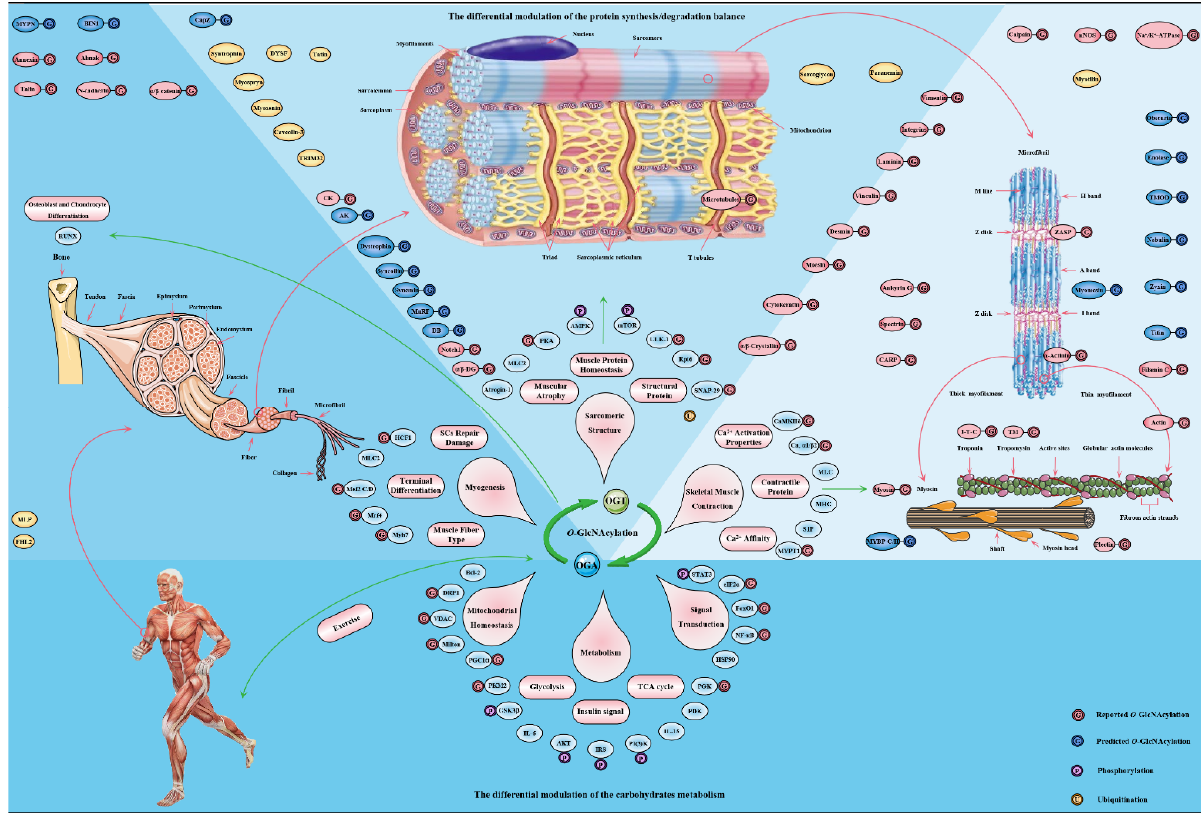
Figure 5. The major targets and pathways shown to be altered by O ‐ GlcNAcylation in in the skeletal muscle physiology . Thousands of O ‐ GlcNAcylated proteins have been identified in skeletal muscle cells. These O ‐ GlcNAcylated proteins are classified into contractile proteins, sarcolemma proteins, structural proteins and cytoskeletal proteins, as well as mitochondrial proteins, metabolic enzymes, transcription factors and signal proteins. Therefore, the effects of O ‐ GlcNAcylation on various phys ‐ iological processes of skeletal muscle may be realized from the following four aspects: ( 1 ) its regu ‐ lation of carbohydrate metabolism with sensing nutritional availability; ( 2 ) its maintenance of struc ‐ tural protein synthesis/degradation balance; ( 3 ) its improvement of sarcomere contractile activity by modulating the calcium activation properties; ( 4 ) its promotion of adaptation and protection un ‐ der exercise and certain adverse circumstances. 5. Conclusions and Perspectives In the past few decades, the molecular mechanism and biological function of O ‐ Glc ‐ NAcylation have been thoroughly studied. However, the physiological mechanisms by which OGT and OGA accurately identify thousands of substrates and dynamically main ‐ tain their O ‐ GlcNAcylation homeostasis remain to be further clarified. One of the current obstacles is that it is difficult to obtain OGT and OGA crystals in higher organisms. An ‐ other obstacle is the identification of precise sites of O ‐ GlcNAcylation. This will be an ur ‐ gent difficulty to overcome and a research node worth exploring. Meanwhile, the research of efficient and specific inhibitors of OGT and OGA has always been a hotspot. The solu ‐ tion of these difficulties will depend on innovative biotechnology and strategies in the future. For example, the calculation and prediction of O ‐ GlcNAcylation site of proteins is an interesting research direction. O ‐ GlcNAcylation ‐ mediated glucose homeostasis and the insulin sensitivity of skele ‐ tal muscle endow the plasticity of metabolic properties to adapt to nutritional availability and physiological clues. However, changes in the fine characterization of global O ‐ Glc ‐ NAcylation of skeletal muscle are extremely complex, depending on muscle fiber type,